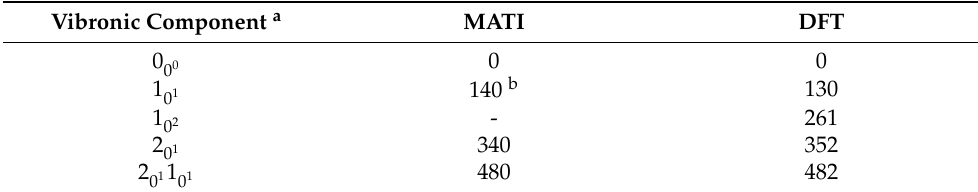
Figure 3. The experimental ( a ) and DFT-simulated ( b ) vibronic structure of the Cp* 2 Mn MATI spectrum. Table 1. Relative positions (cm − 1 ) of the vibronic components in the Cp* 2 Mn experimental MATI spectrum and its DFT